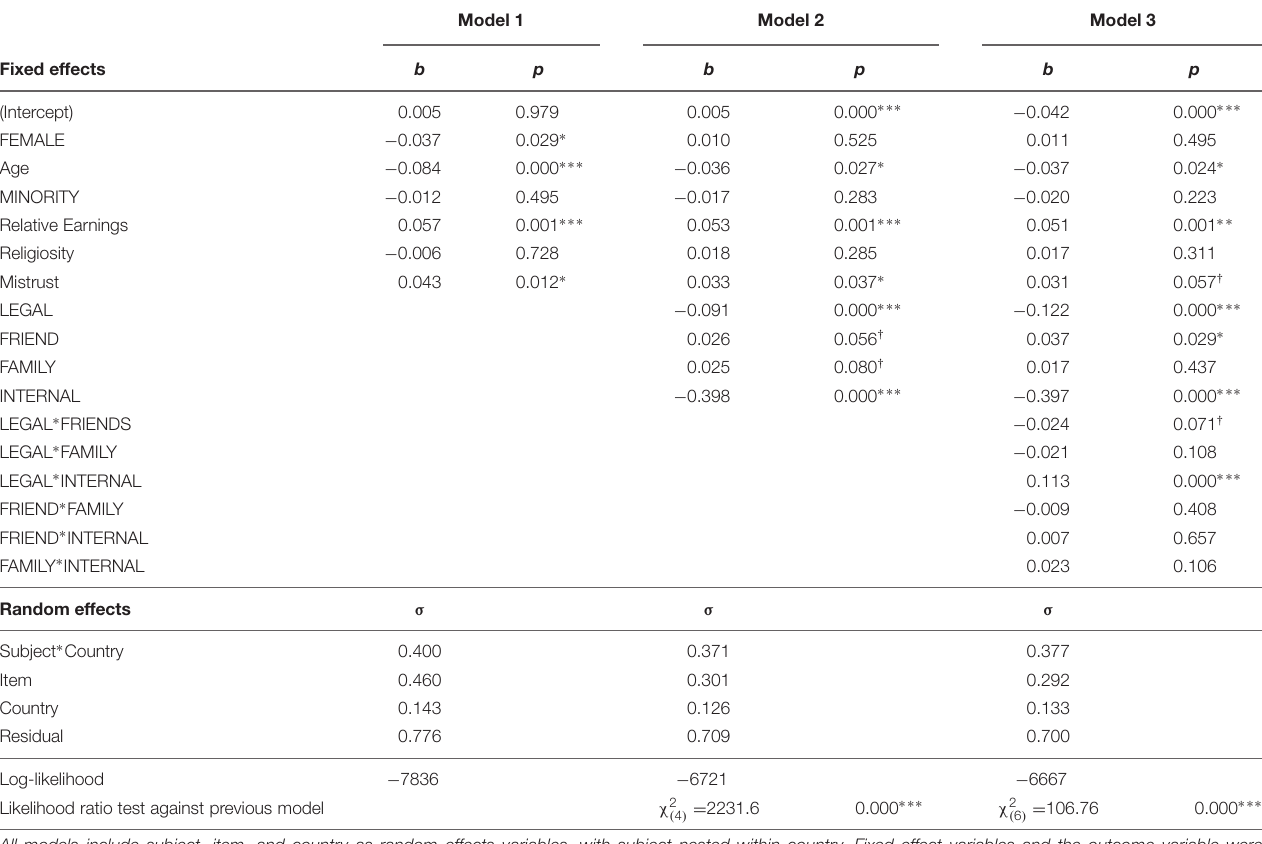
TABLE 2 | Results from linear mixed effects models with ML estimation for likelihood of engaging in